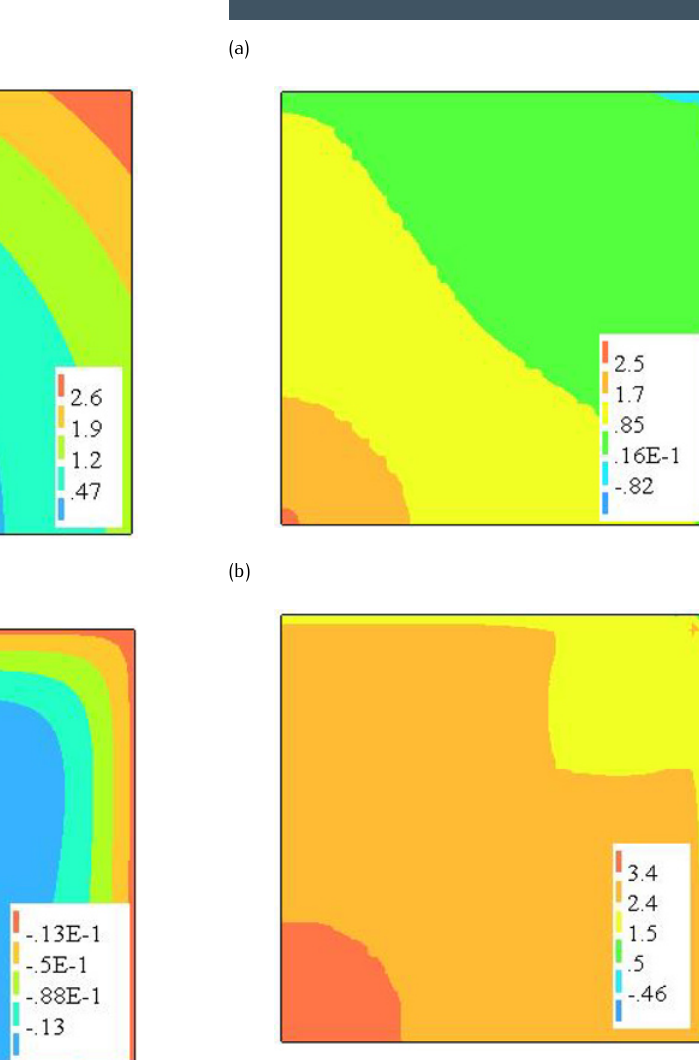
Figure 23. Principal tensile stress at top surface [N/mm 2 ], (a) Free boundaries, (b) Fixed